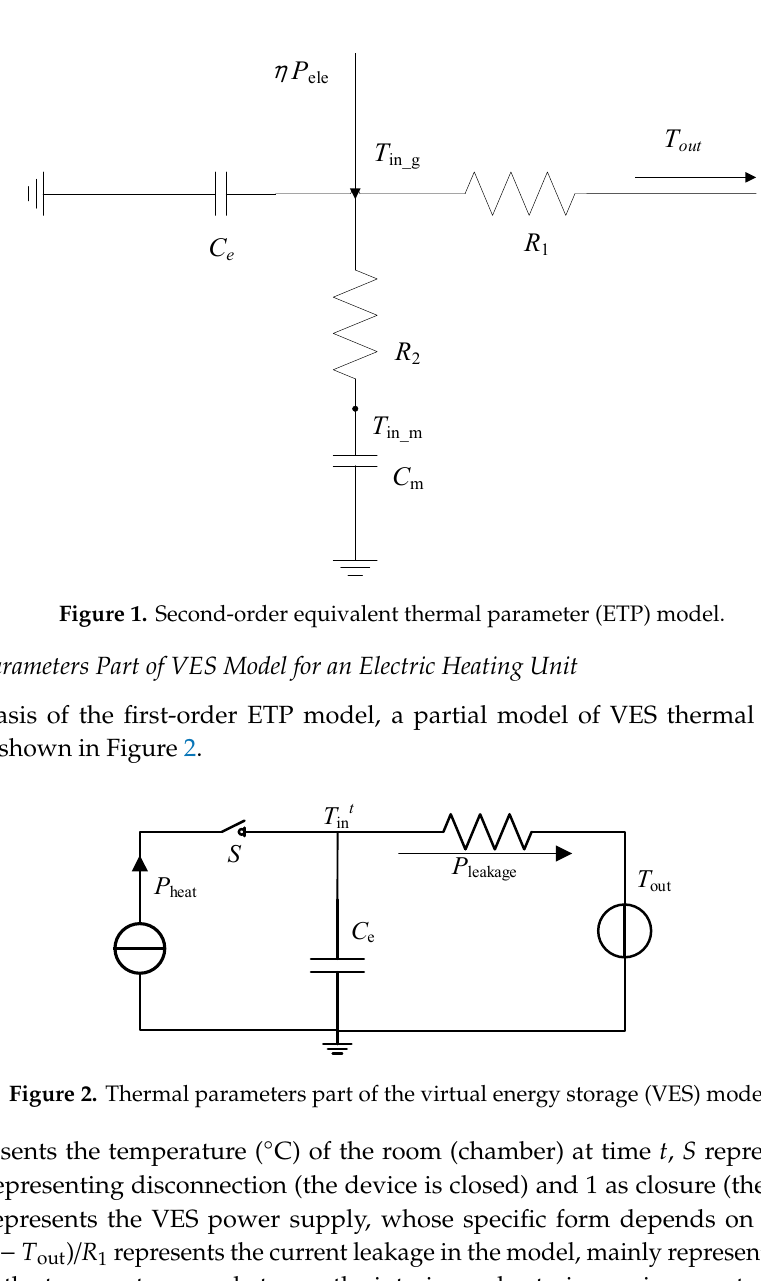
Figure 2. Thermal parameters part of the virtual energy storage (VES) model.